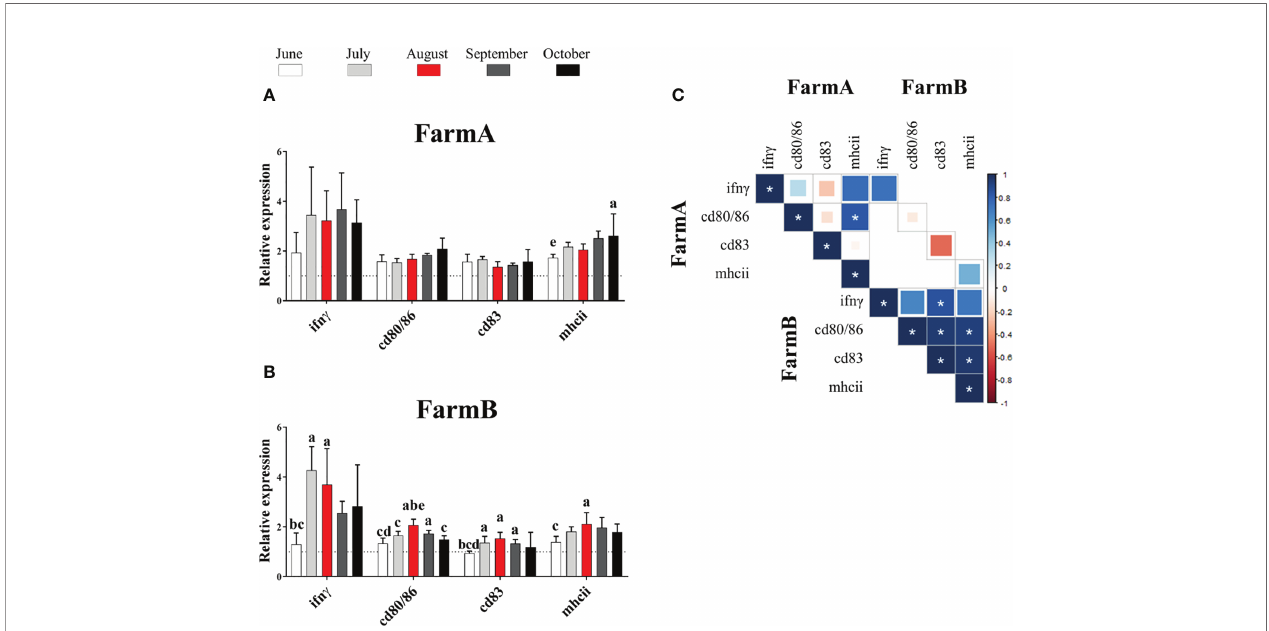
FIGURE 5 | Gene expression of ifn g and cell-surface markers ( cd80/86 , cd83 and mhcii ) in the spleen of fi sh from two fi sh farms. FarmA (A) and FarmB (B) during the time period June – October 2018. The data were plotted in bars (n = fi ve pools, 10 fi sh per pool) using relative expression in fold of change. Lowercase letters (a, b, c, d and e): signi fi cant differences ( P < 0.05) compared to June, July, August, September and October, respectively by Tukey ’ s multiple comparison test. In white: June. In light gray: July. In red: August. In dark gray: September. In black: October. (C) Correlation of gene expression data from spleen samples of Atlantic salmon. *: the signi fi cant proportional relationship between two groups of data ( P <